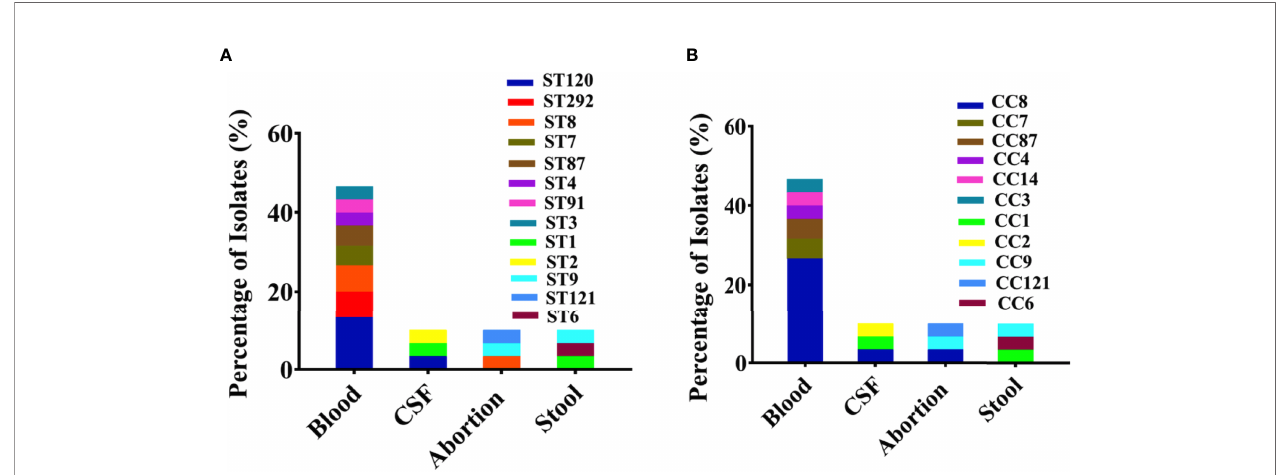
FIGURE 2 | Genetic background with sequence types (STs) and clonal complexes (CCs) for all clinical Listeria monocytogenes isolates. (A) Major sequence types (STs) representing individually each group/category of blood, abortion, cerebrospinal fl uid (CSF), and stool isolates (n = 60) are shown with colors. (B) Major CCs representing individually each group/category of blood, abortion, CSF, and stool isolates (n = 60) are shown with colors.